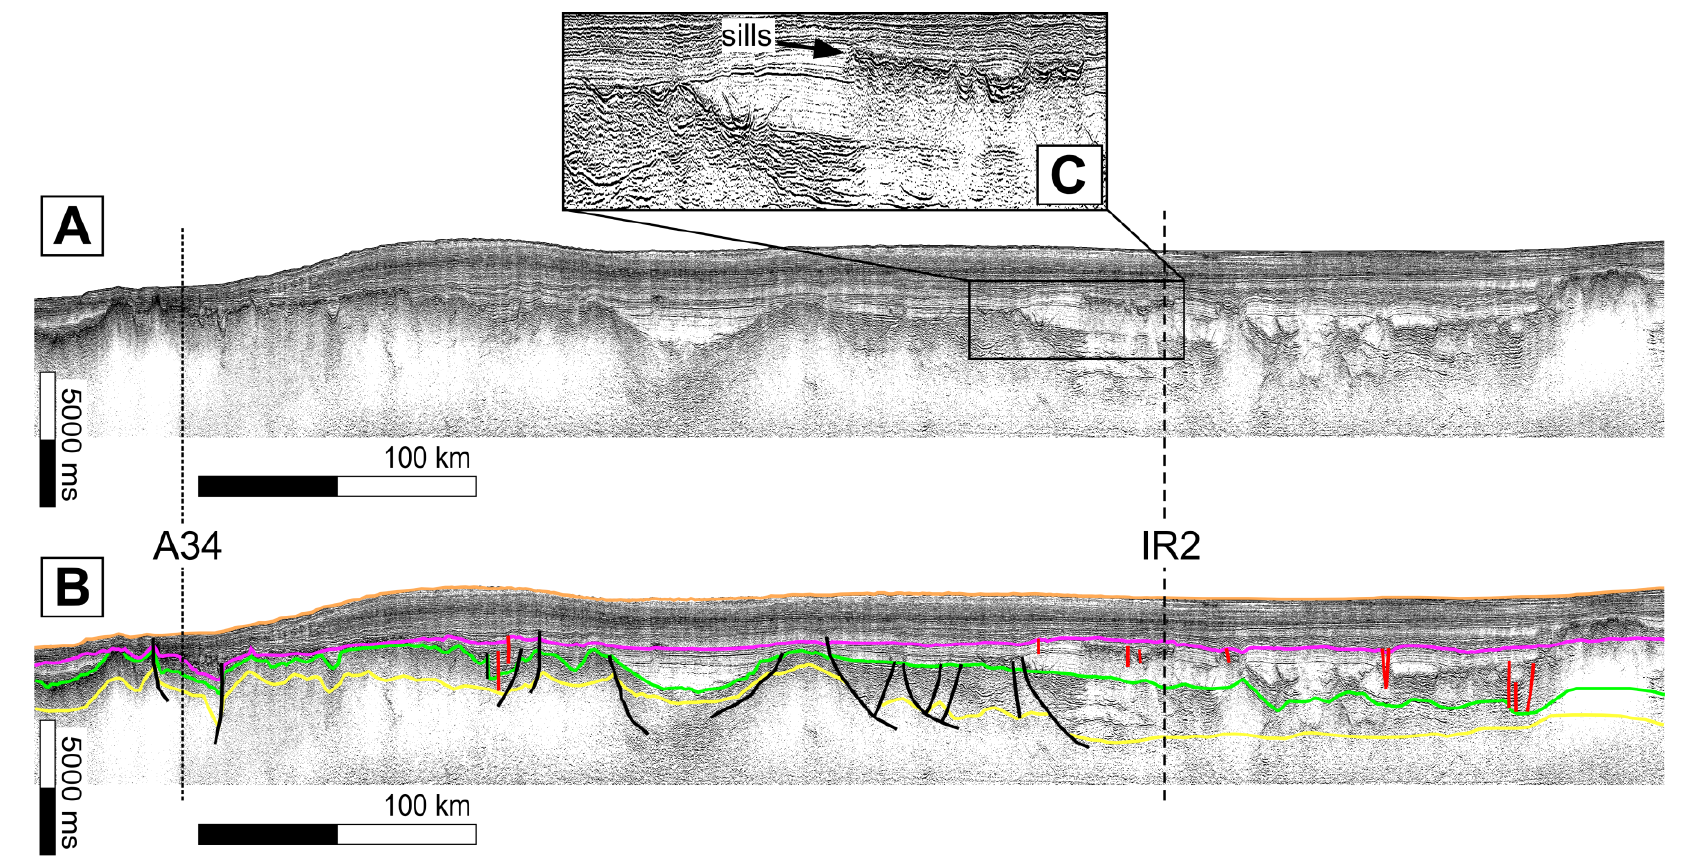
Figure 5. ( A ) Uninterpreted seismic line IR1 in the Rockall Basin (blue line in Figure 1C). The dotted black line depicts the intersection of magnetic Chron A34 with seismic line IR1. ( B ) Interpreted seismic line IR1. Seismic horizons: basement, yellow; top of Lower Cretaceous, green; top of Upper Cretaceous, pink; top of Cenozoic, orange. Solid black lines represent primary faults and solid red lines represent secondary faults. The dashed black line indicates the intersection with IR2. ( C ) Enlarged section of IR1 showing sills that obscure deeper reflections.